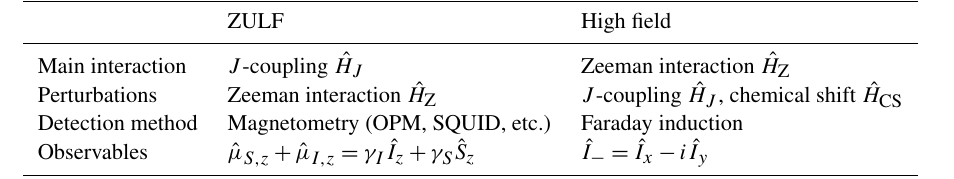
Table 2. Comparison between high-field and ZULF NMR for typical experiments. Note that quadrature detection (and thus imaginary signals) is possible at ZULF, although uncommon. SQUID stands for superconducting quantum interference device.